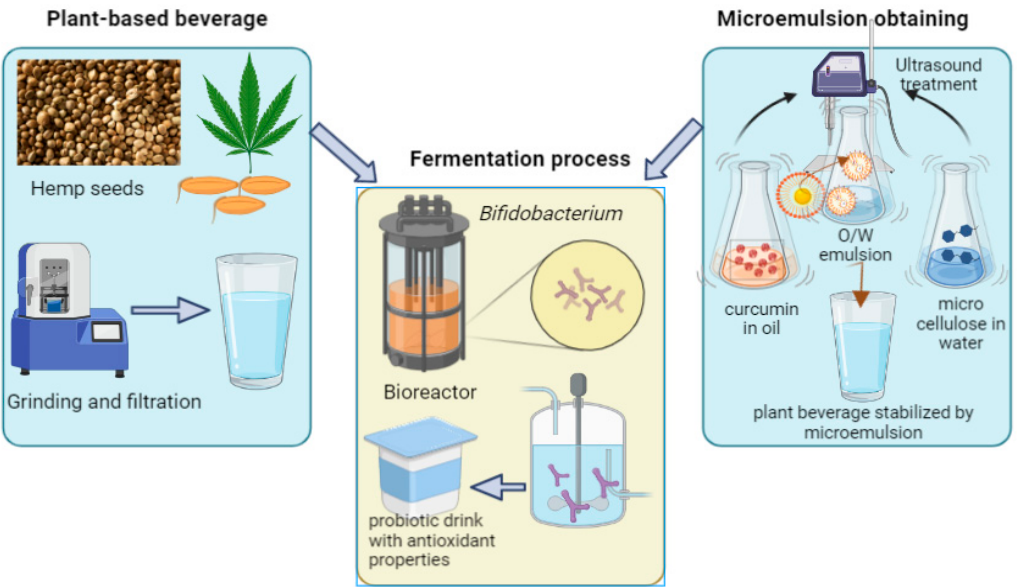
Figure 2. Technological stages for obtaining fermented drinks stabilized with ME. (Created with BioRender.com).